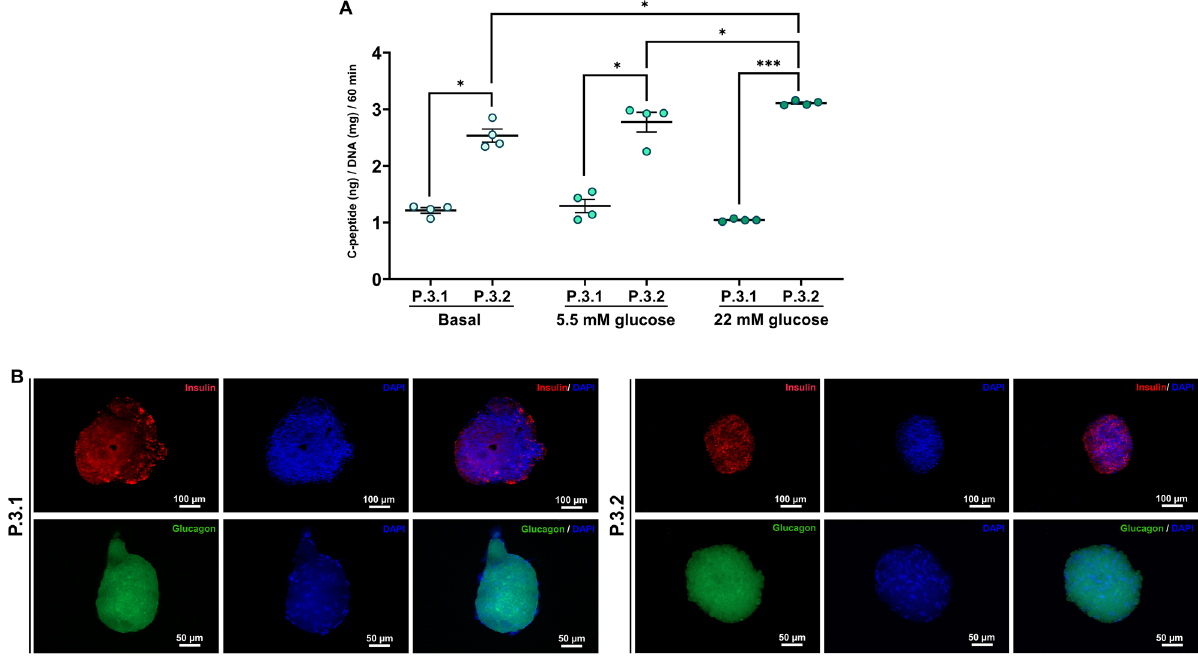
Figure 6. Functionality of cAD-MSC-derived IPCs. C-peptide secretion was determined by glucose-stimulated C-peptide secretion (GSCS) assay ( A ). The expression of Insulin and Glucagon by cAD-IPCs was detected by immunocytochemistry on day 13 by immunocytochemistry and observed under fuorescent microscope ZEISS Apotome.2 (Carl Zeiss, Germany) incorporated with Axio Observer Z1 and ZEN pro sofware (ZEISS International, Germany) at 10X (Insulin) and 20X (Glucagon) ( B ). Bars indicates the significant differences (*, p value < 0.05; ***, p value <